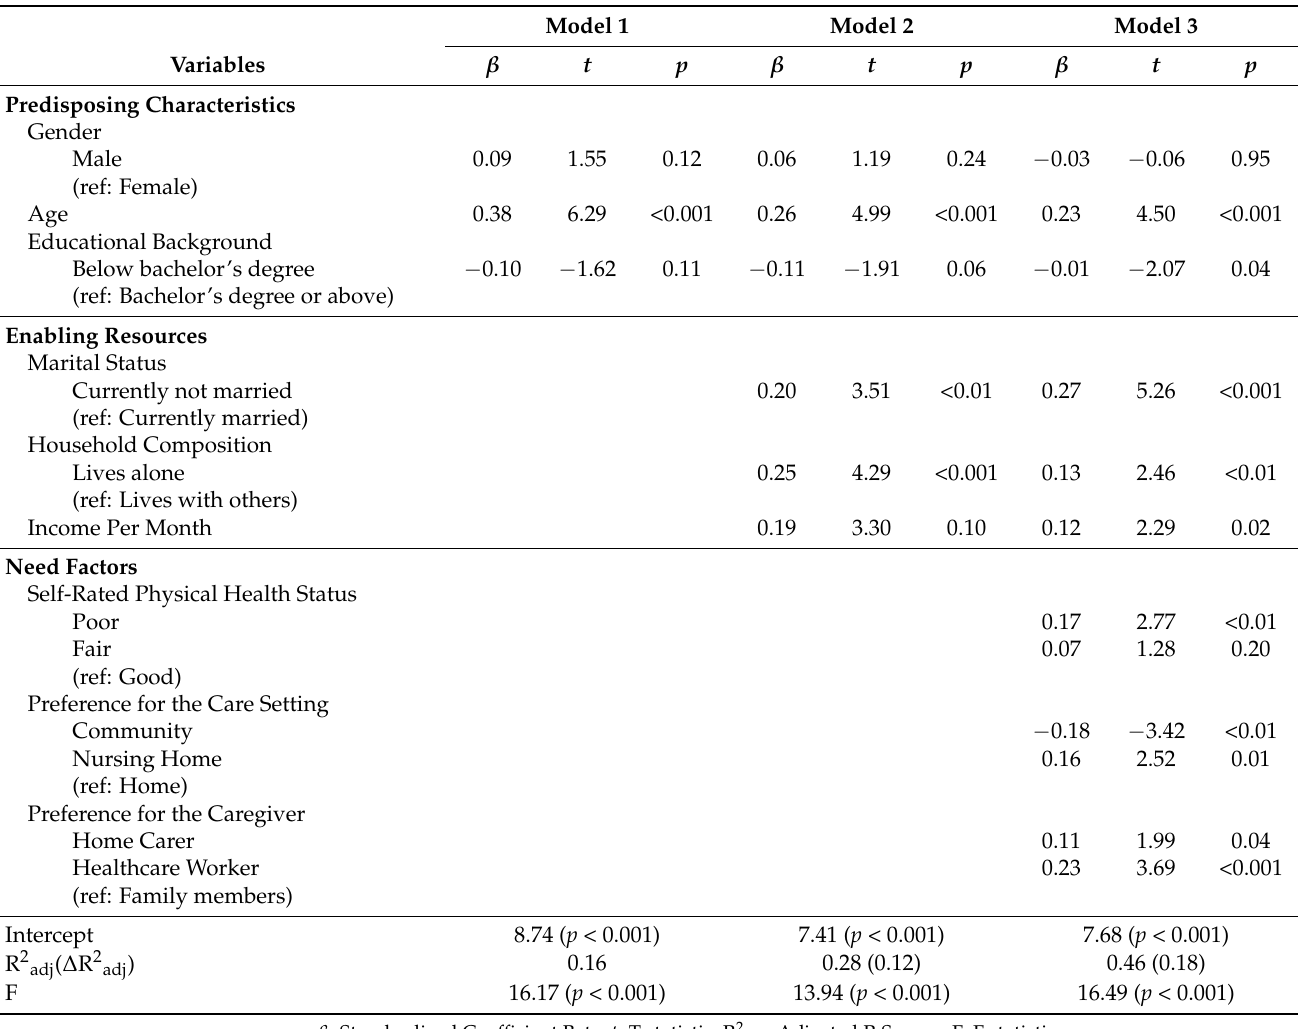
Table 6. Hierarchical Regression Analysis of Factors Influencing the Intended Use of Psychological